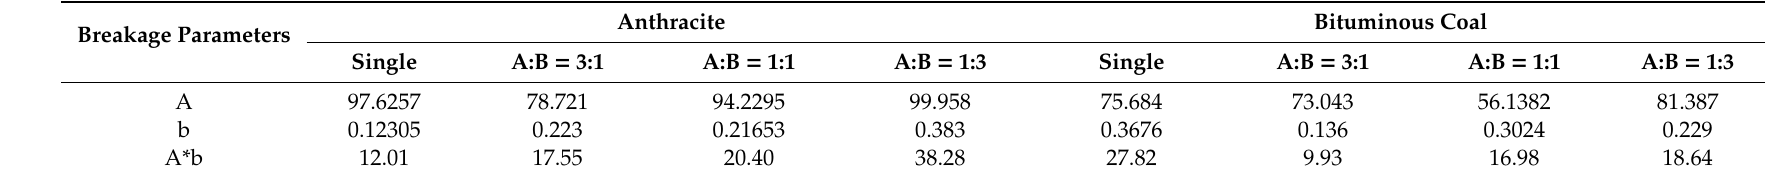
Table 5. Breakage parameters of